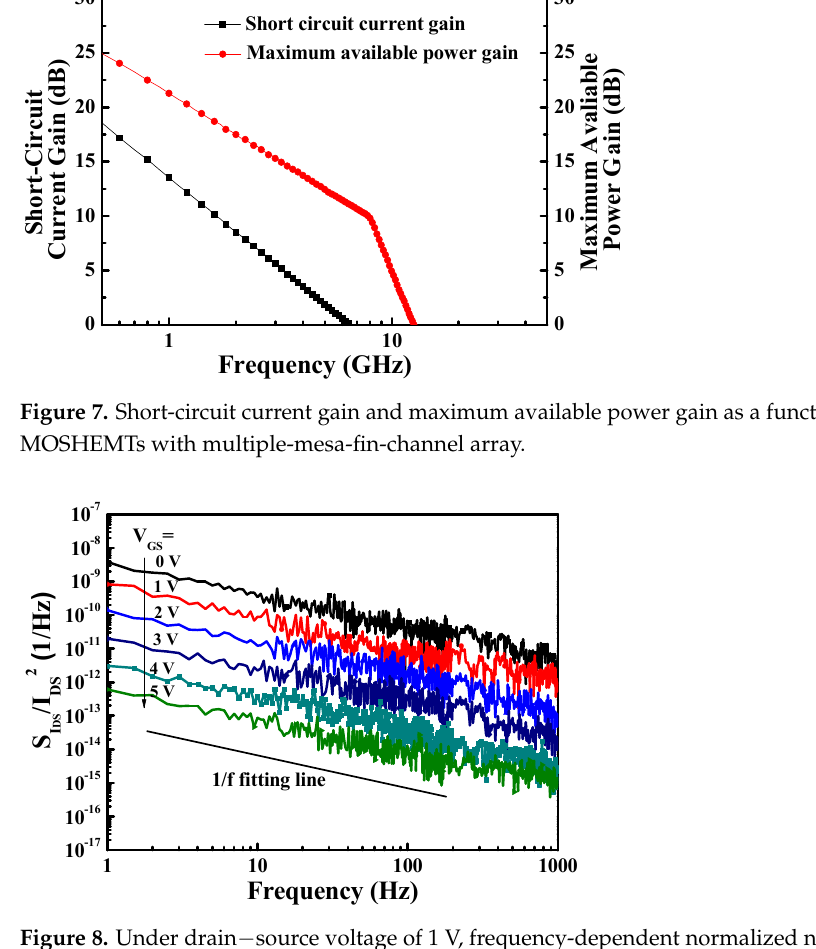
Figure 8. Under drain−source voltage of 1 V, frequency-dependent normalized noise power spectra of MOSHEMTs with multiple-mesa-fin-channel array.